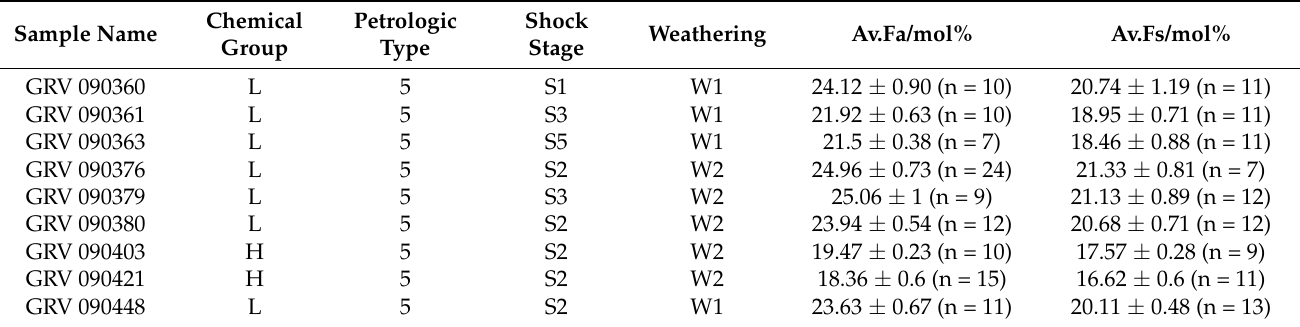
Table 1. Information on the selected meteorite samples (analysis of these sample components was conducted by electronic probes and raw data provided by the Meteoritical Bulletin